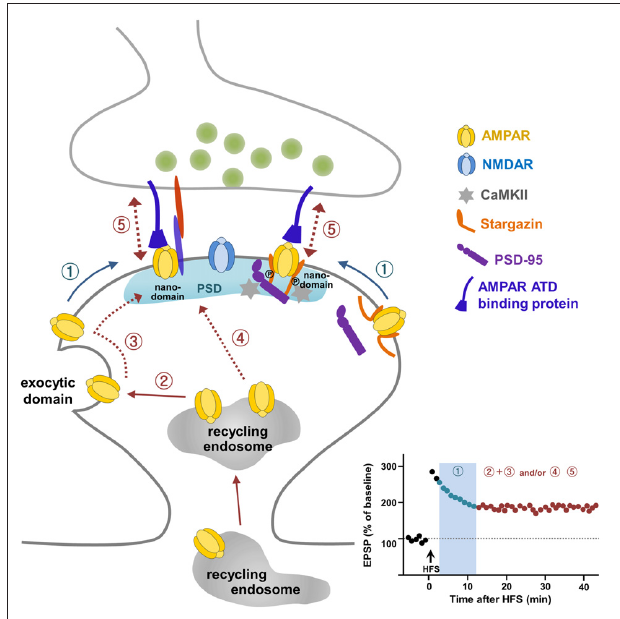
FIGURE 1 | A current model for α -amino-3-hydroxy-5-methyl-4- isoxazolepropionate (AMPA) receptor (AMPAR) trafficking during long-term potentiation (LTP). Pre-existing extrasynaptic surface AMPARs are mobilized to the synaptic sites upon LTP stimulation via lateral diffusion ( (cid:172) ) and are trapped in nanodomains within the synapse, which is required for short-term potentiation ( (cid:172) in LTP graph). AMPARs exocytosed from intracellular recycling endosomes to the exocytic domain adjacent to the postsynaptic density (PSD) replenish the extrasynaptic surface pool of AMPARs ( (cid:173) ), and these exocytosed AMPARs are mobilized laterally to reach the synaptic site ( (cid:174) ) and supply AMPARs for maintaining LTP expression. The direct delivery of a portion of AMPARs on recycling endosomes to the synaptic site during LTP ( (cid:175) ) cannot be ruled out. AMPARs trapped at the synapse are immobilized through the regulation of Stargazin and probably through the subunit-specific regulation of the AMPAR amino-terminal domain (ATD) interacting protein ( (cid:176)